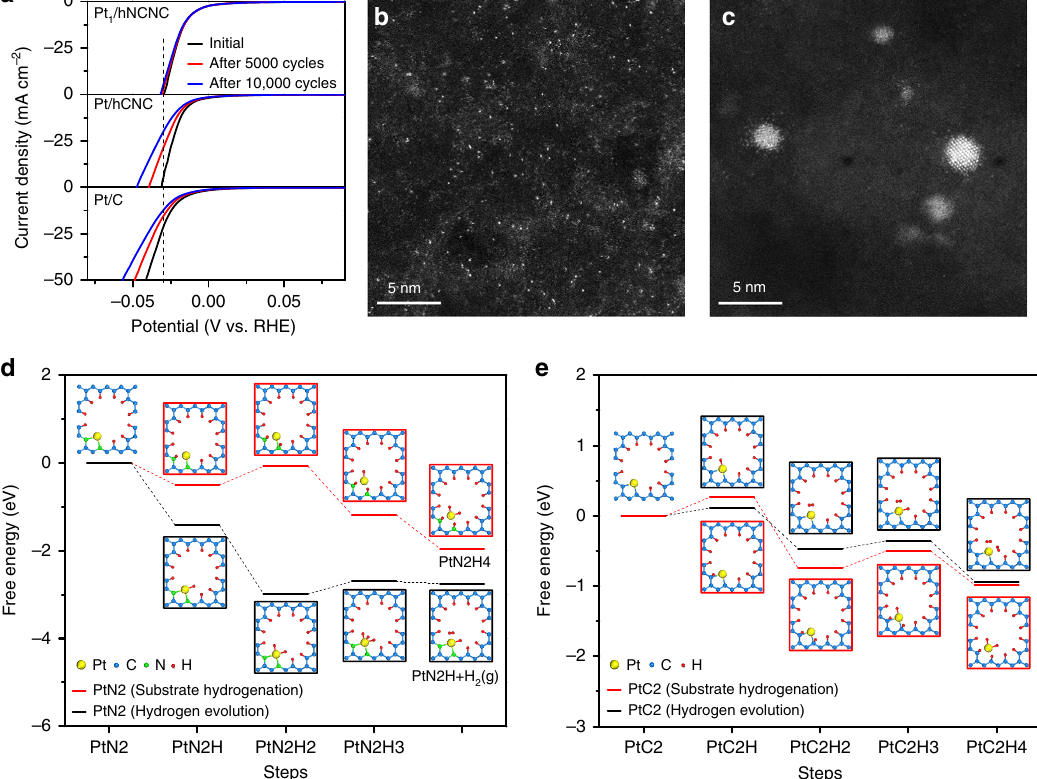
Fig. 4 HER durability of Pt 1 /hNCNC, Pt/hCNC and commercial Pt/C in 0.5 mol L − 1 H 2 SO 4 . a Polarization curves before and after 5000 and 10000 CV scans between 0 and − 0.4 V (vs. Ag/AgCl). b , c HAADF-STEM images of Pt 1 /hNCNC ( b ) and Pt/hCNC ( c ) after 10000 cycles of CV scan. d , e Free energy of the hydrogen evolution and substrate hydrogenation for a Pt atom bonding with two py-N atoms (PtN2) or two carbon atoms (PtC2), respectively. The corresponding optimized structures are presented